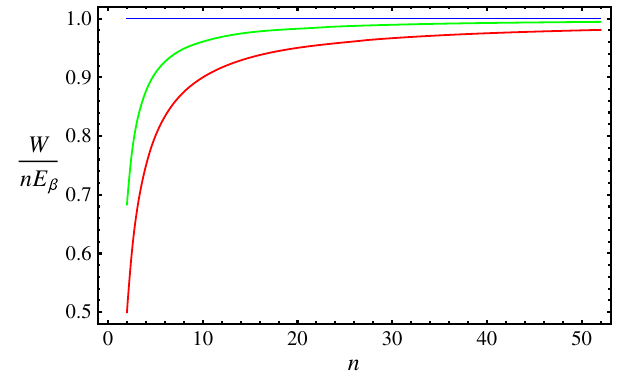
FIG. 1. Extractable work from entangled (blue line), separable (red line), and entangled but having the same entropy as the separable (green line) states in units of the initial total energy of the system. Specifically, we take the states Eqs. (7), (8), and (11) for d ¼ 2 , β E 1 ¼ 1 . As n increases, classical states become able to store essentially the same amount of work as quantum